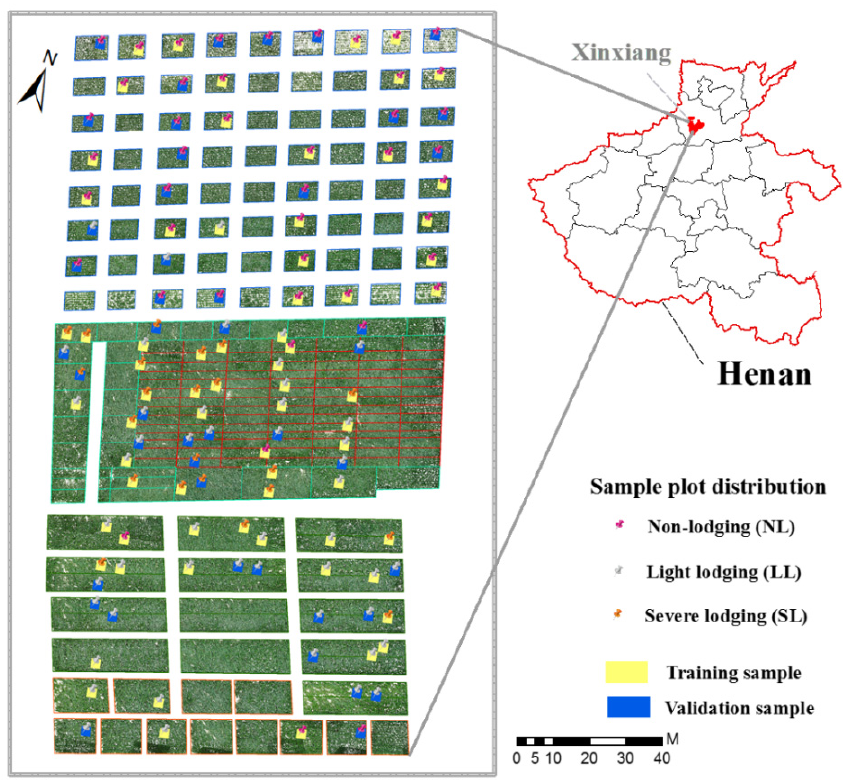
Figure 3. Sample plots distribution with different lodging